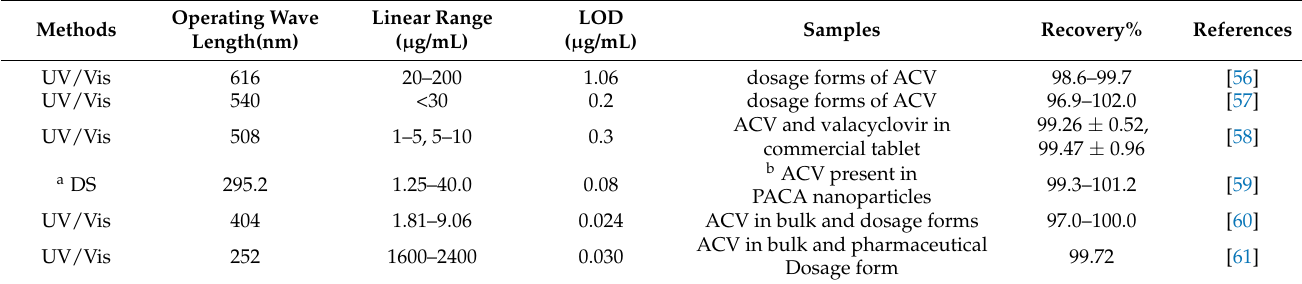
Figure 3. Proposed reaction pathway between ACV and ninhydrin–ascorbic acid (reproduced with permission [57], copyright 2015, Ukpe Ajima and Johnson Ogoda Onah). Table 6. Various spectrophotometry methods for the detection of ACV.